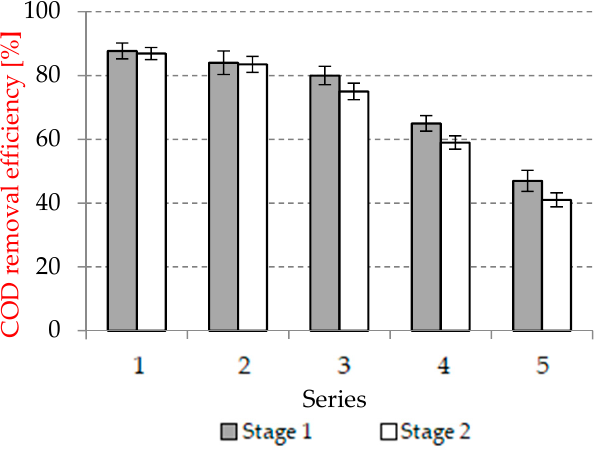
Figure 4. COD removal efficiency.